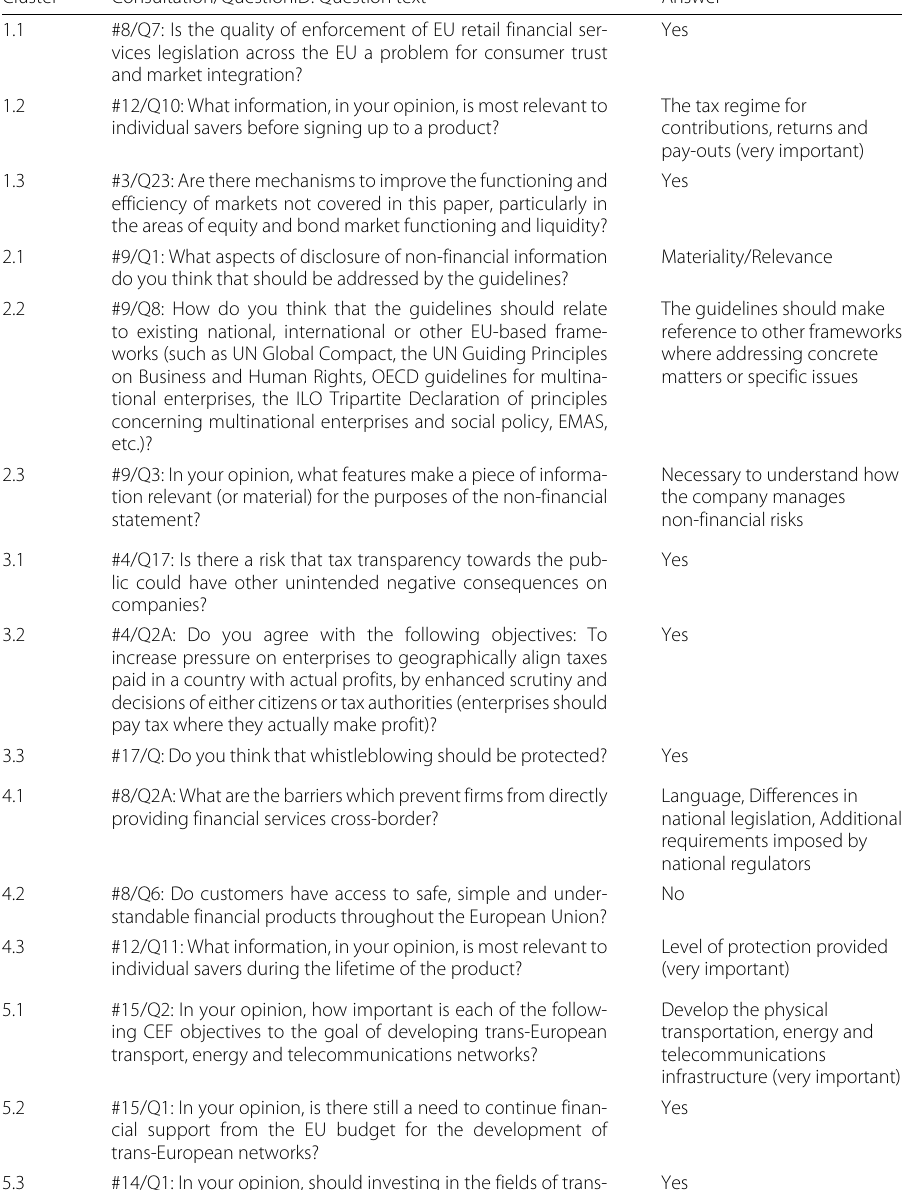
Table 6 Prototypical questions and answers for each co-voting